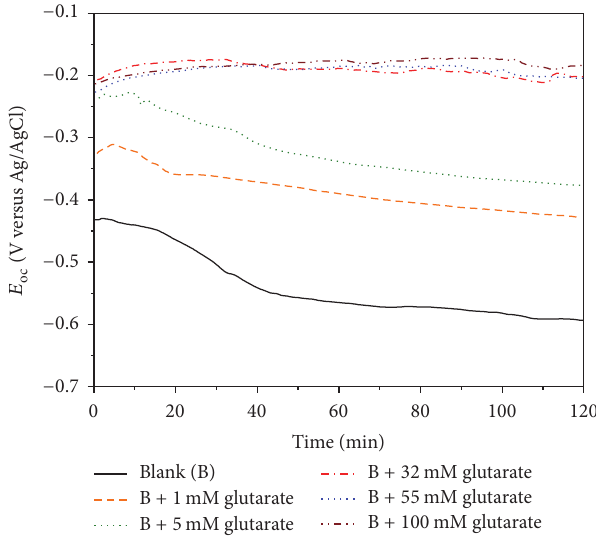
Figure 1: Variation with time of open circuit potential for carbon steel in air saturated 0.02 M NaCl solutions without and with additions of sodium